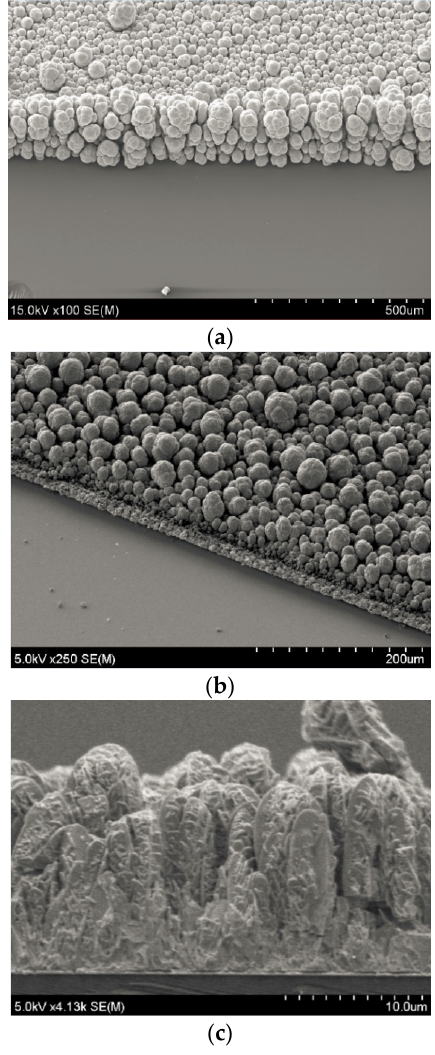
Figure 8. Morphology of the thick BiTe film synthesized by the constant potential method: ( a ) 200- μ m-thick film; ( b ) cross-section view of the 200- μ m-thick film consisting of two different layers; and ( c ) cross-section structure of the initial 10- μ m-thick film.